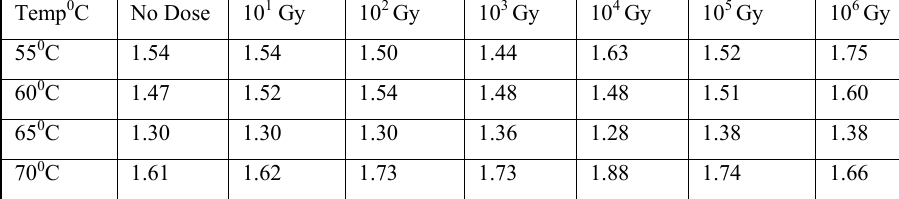
Table 6. Etch-Rate ratio for post-gamma exposed PADC –American Acrylics.